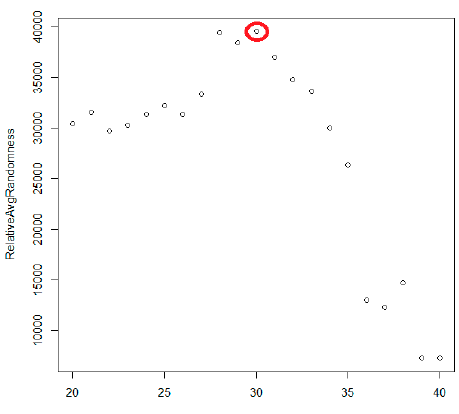
Figure 2. Considering the structure of an IP address, we defined an index of sparsity based on a random sample of IP addresses. This absolute index was relativized using a cost function exponential in the sample size. Repeated experiments showed that 30 is a good number for the size of a sample.